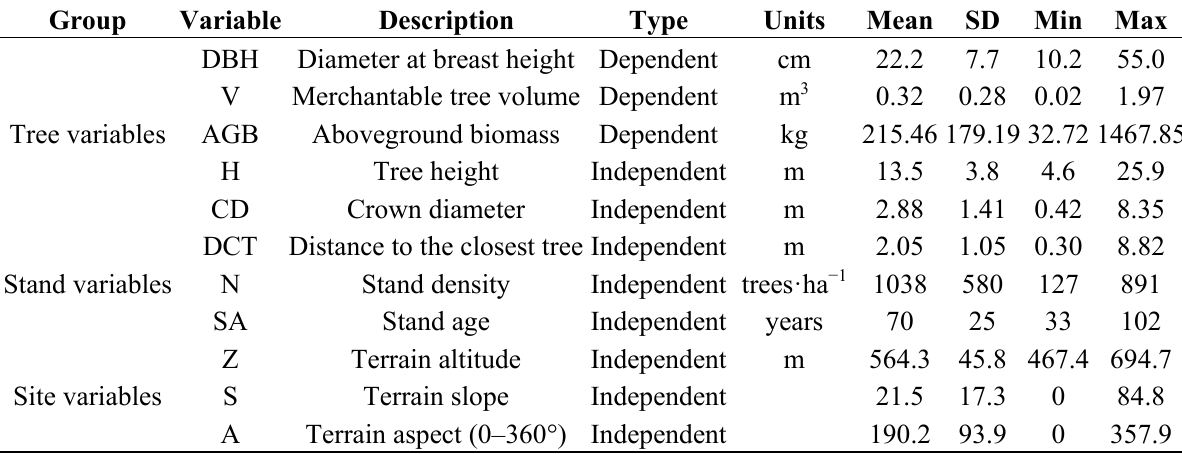
Table 2. Description and descriptive statistics (Mean, SD—standard